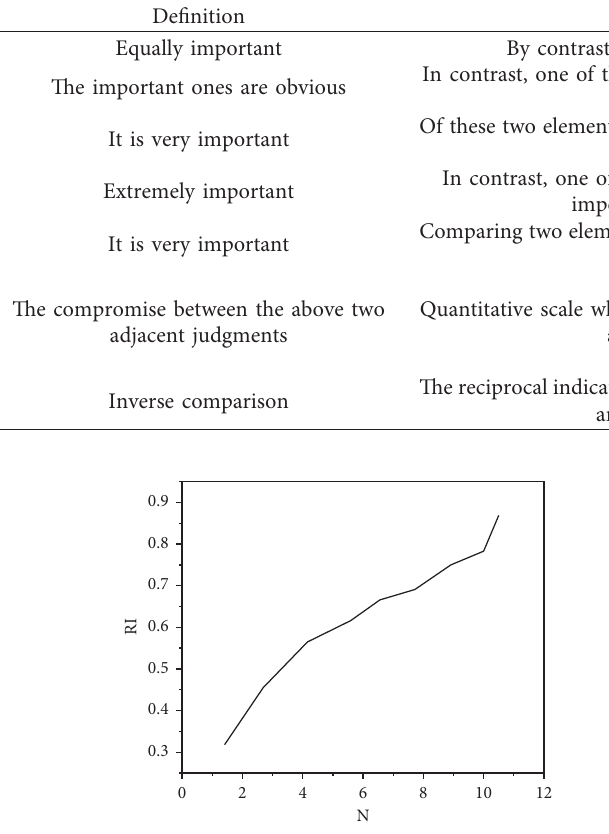
Table 4: Comparison and judgment value of each element.